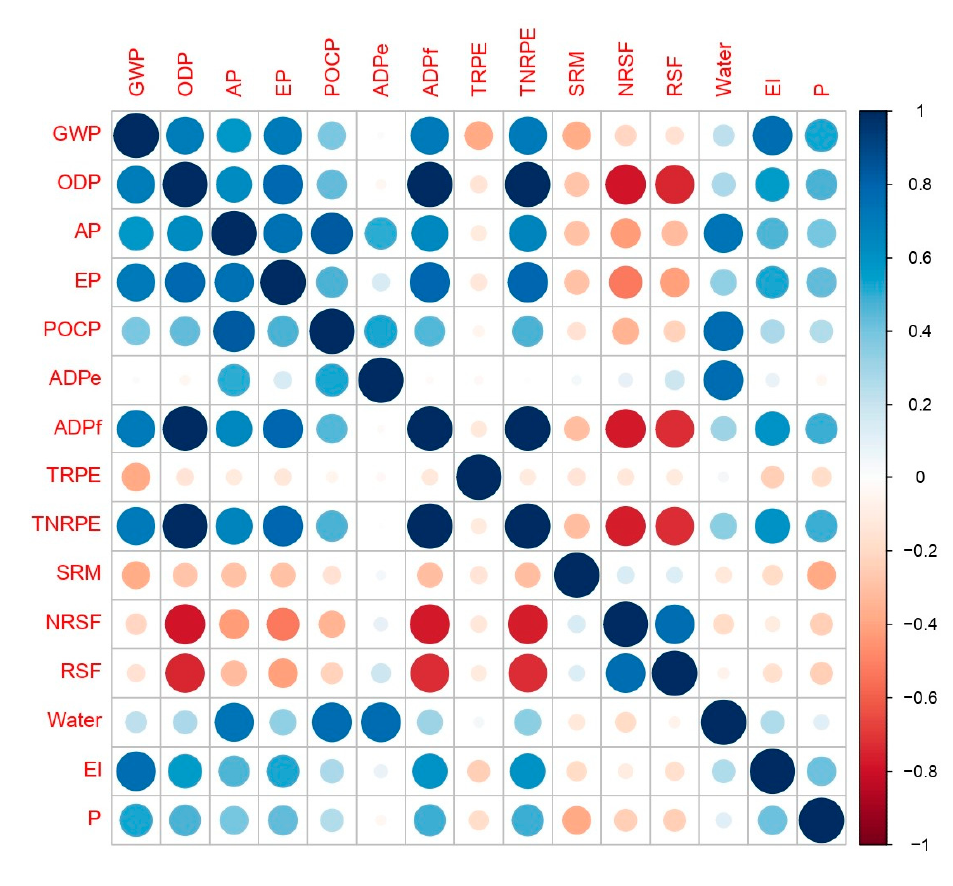
Figure 1. Correlation matrix of ICs. Table 2. Classes of ICs.